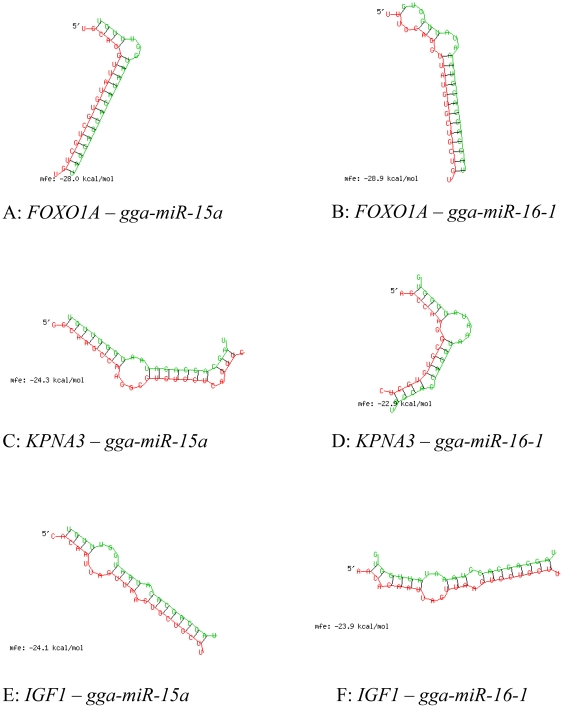
Molecular interactions between microRNAs and three prime untranslated regions (3′UTR) of FOXO1A, KPNA3 and IGF1.Red letters indicate the 3′ UTR sequences of the target genes. Green letters indicate the matured sequences of gga-miR-15a or gga-miR-16-1.